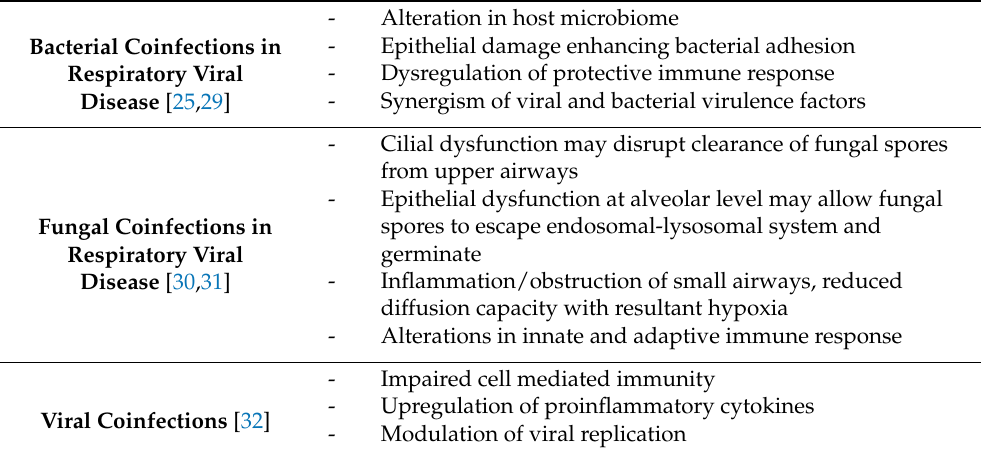
Table 1. Summary of mechanisms contributing to